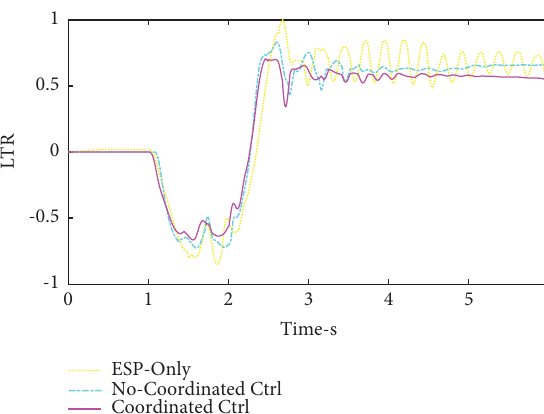
Figure 7: Te variation curve of LTR with time.